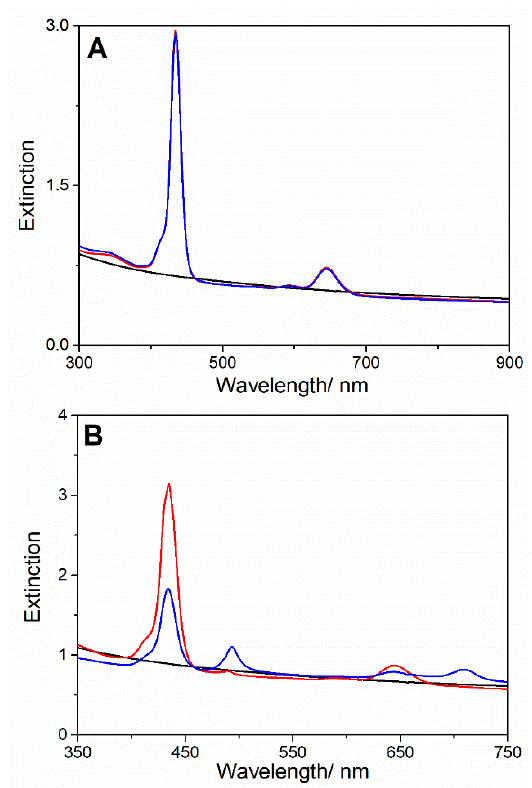
Figure 4. UV-Vis spectra of MWCNT-EDA (black line) and upon TPPS addition (red line), and 1 day after mixing (blue line) ( A ), and of MWCNT-EPA (black line), upon TPPS addition (red line), and 1 day after mixing (blue line) ( B ). Experimental conditions: [TPPS] = 5 µM; MWCNT-EDA or MWCNT-EPA = 0.02 mg/mL; 10 mM citrate buffer at pH 2.4; PL protocol; T = 298 K.